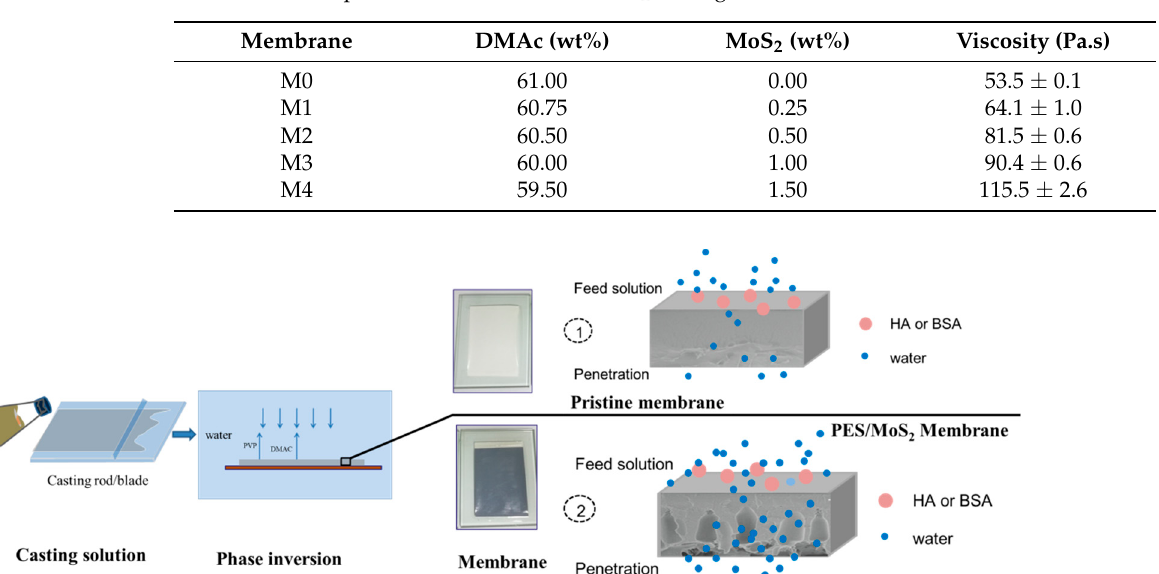
Table 1. The composition of PES and PES/MoS 2 casting solutions.